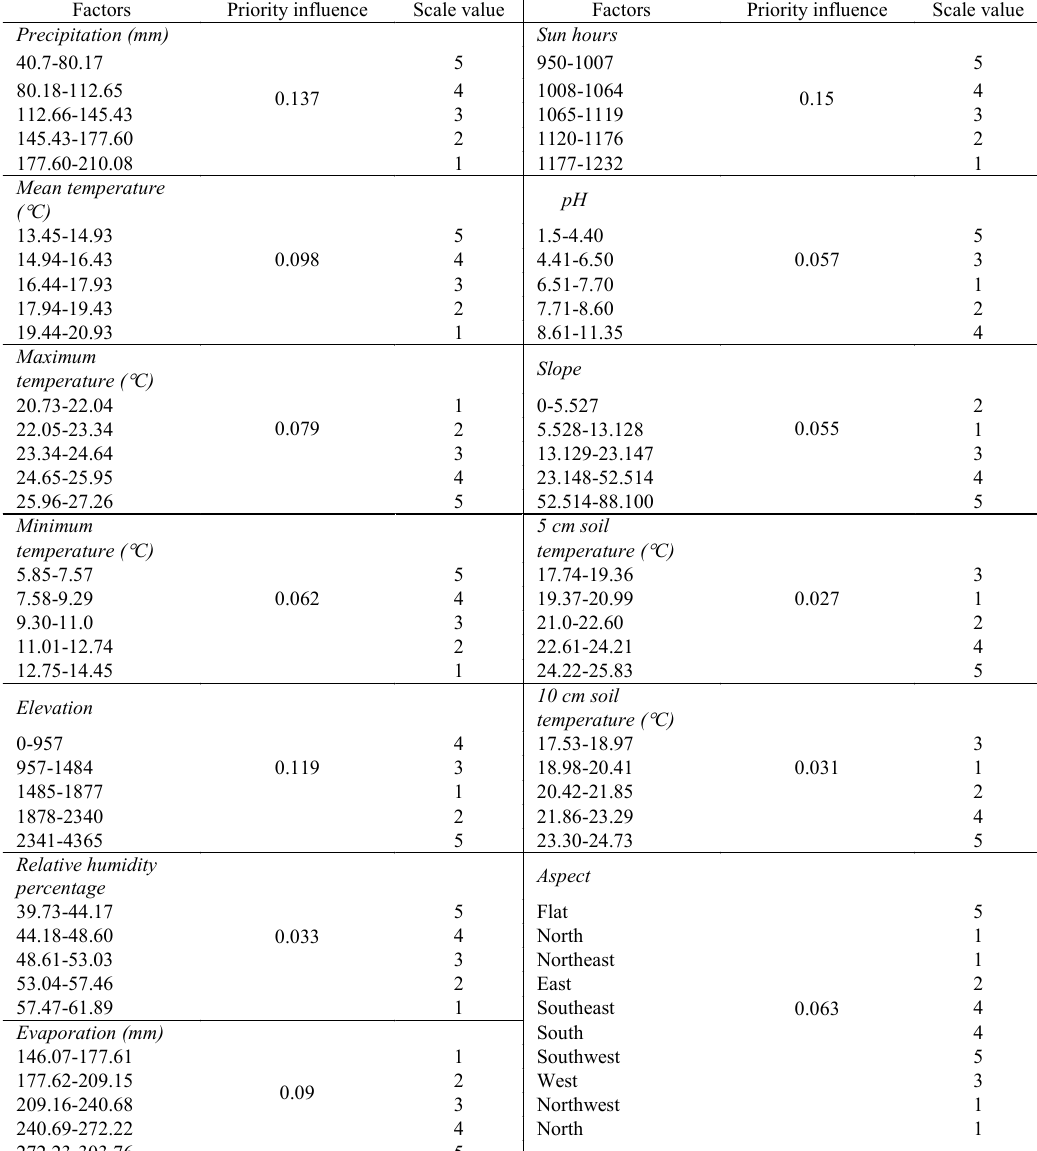
Table 4: Factors, priority influence and scale value of the data layers according to the questionnaire